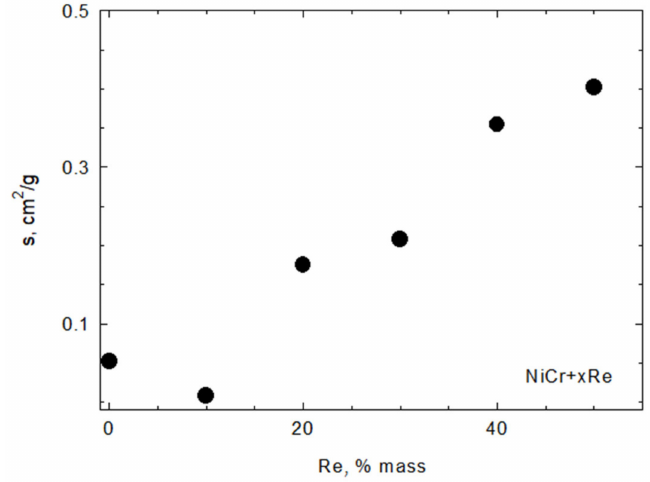
Figure 8. Specific surface area of NiCr + xRe powders.